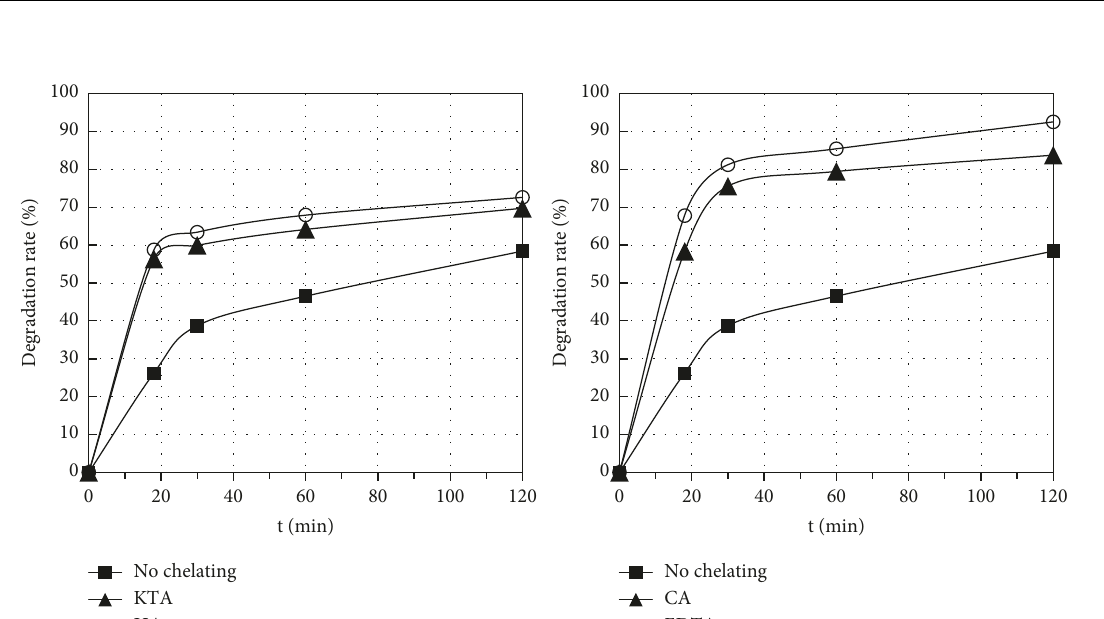
Figure 11: Comparison of the effect of four small-molecule carboxylic acids on the degradation promotion efficiency of the Fe reaction